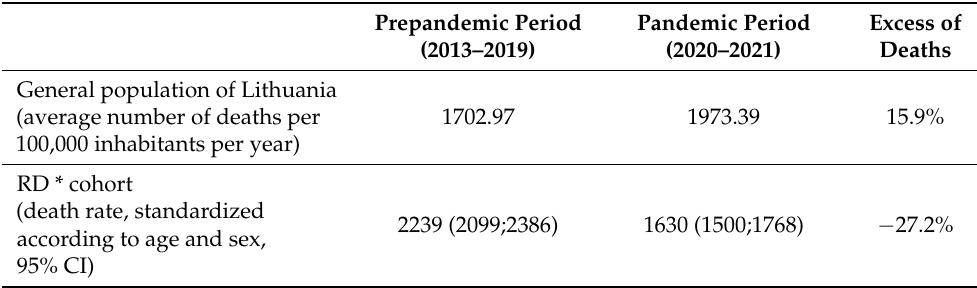
Table 3. Death rates and excess of deaths observed in the general population of Lithuania and the cohort of rheumatic diseases during the prepandemic and pandemic periods.